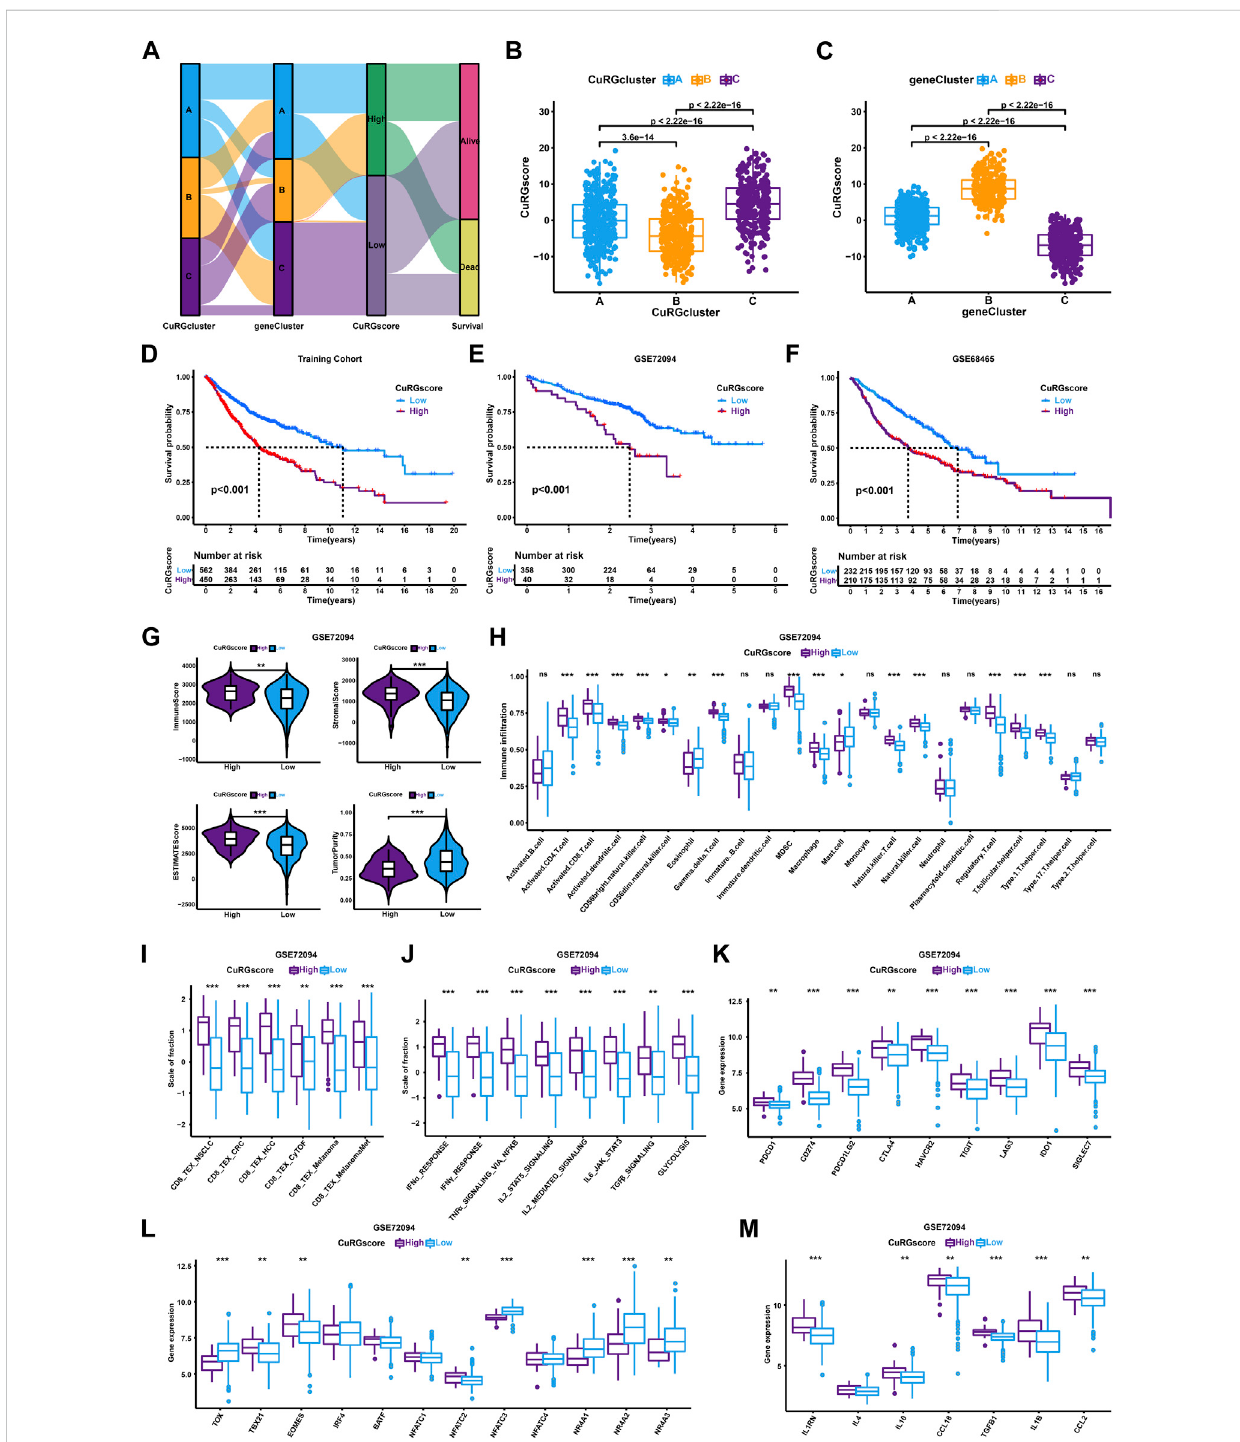
FIGURE 4 TEX and TIME Characterisation of the CuRGscore in training and external validation cohorts. (A) Alluvial diagram showing the relation of patients in CuRGcluster, geneCluster, CuRGscore, and survival status. (B, C) Differences of CuRGscore among three CuRGclusters (B) and geneClusters (C) in the training cohort (GSE30219, GSE31210, GSE37745, GSE50081, TCGA-LUAD; Kruskal – Wallis test). (D – F) Survival analyses for the high- and low- CuRGscore groups in the training cohort (D) and two independent external cohorts, GSE72094 (E) and GSE68465 (F) . (G) Immune, stromal, ESTIMATE, and tumor purity scores in high- and low-CuRGscore groups. (H) The abundance of each TME in fi ltrating cells in high- and low-CuRGscore groups. (I – M) GSVA enrichment analysis in high- and low-CuRGscore groups with TEX-related signatures (I) , signaling pathways (J) , checkpoint genes (K) , transcription factors (L) , and in fl ammatory factors (M) . The line in the box represents the median value, and the asterisk represents the p -value. * p < 0.05; ** p < 0.01; *** p <